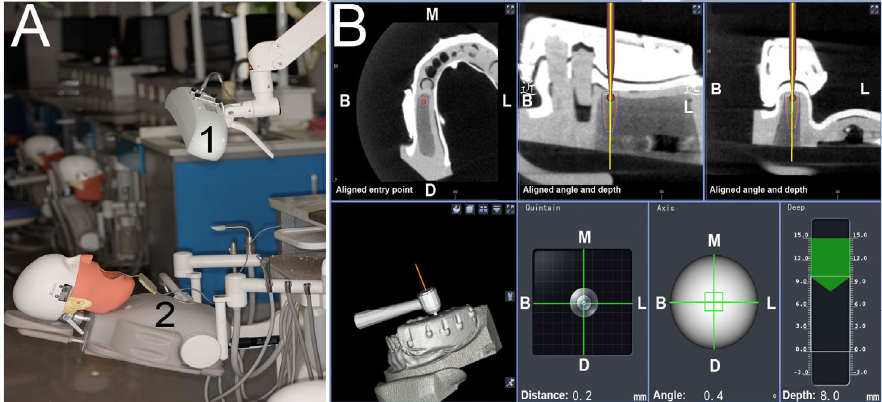
Figure 3. The dynamic navigation system. ( A ) Dcarer ® work diagram: 1-infrared receiver (optical camera), 2-reference board; ( B ) Dcarer ® software interface during surgical procedures. B: Buccal, L: Lingual, M: Mesial, D: Distal.